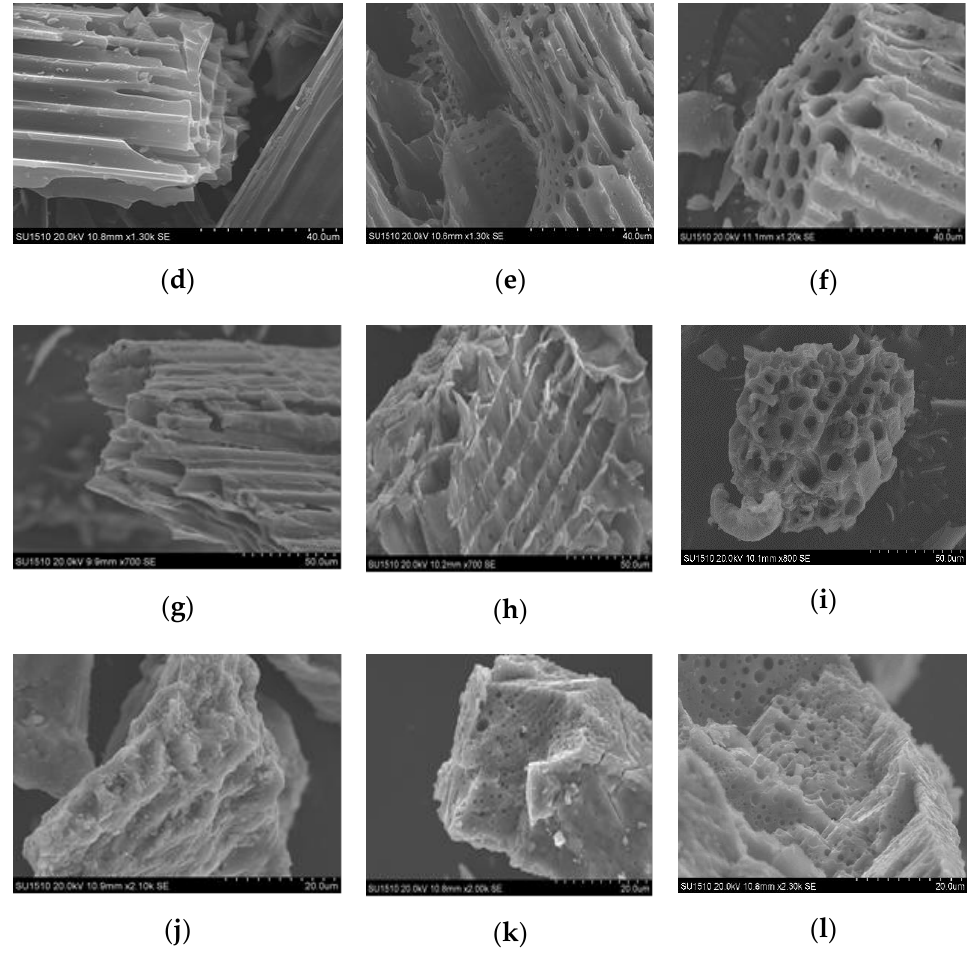
Figure 1. Scanning electron microscope (SEM) photos of RSB300 ( a ), RSB500 ( b ), RSB700 ( c ), PCB300 ( d ), PCB500 ( e ), PCB700 ( f ), SDB300 ( g ), SDB500 ( h ), SDB700 ( i ), ESB300 ( j ), ESB 500 ( k ) and ESB 700 ( l ), respectively.